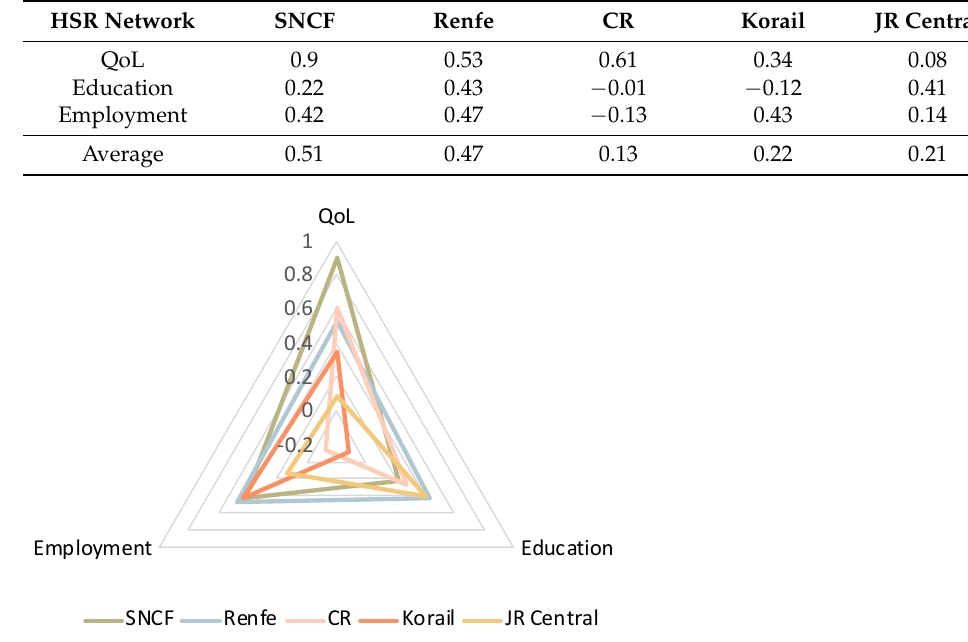
Table 4. The summarisation on PCC results in QoL, education and employment of each HSR network.